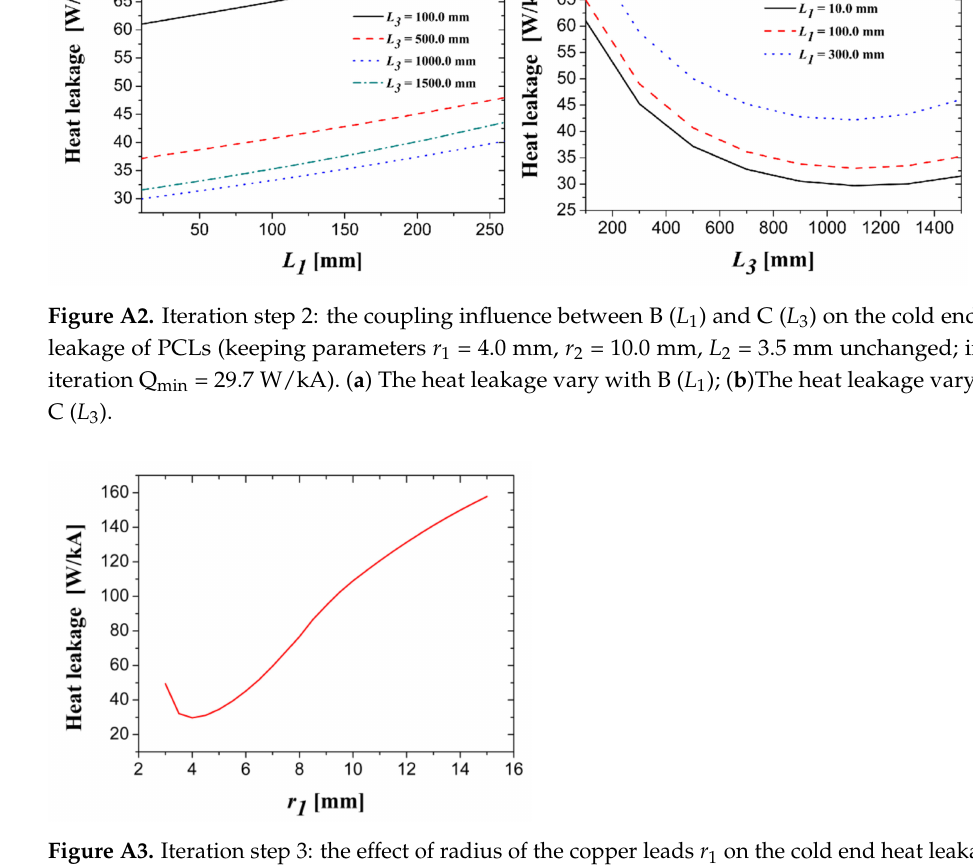
Figure A3. Iteration step 3: the effect of radius of the copper leads r 1 on the cold end heat leakage of PCLs (keeping parameters L 1 = 10.0 mm, L 3 = 1100.0 mm, r 2 = 10.0 mm, L 2 = 3.5 mm unchanged; in this iteration Q min = 29.7 W/kA).